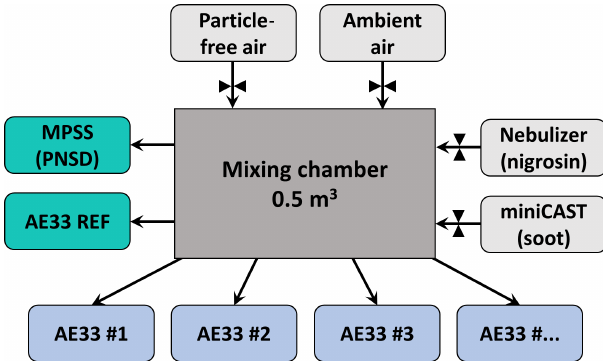
Figure 3. Experimental setup used in the intercomparisons.